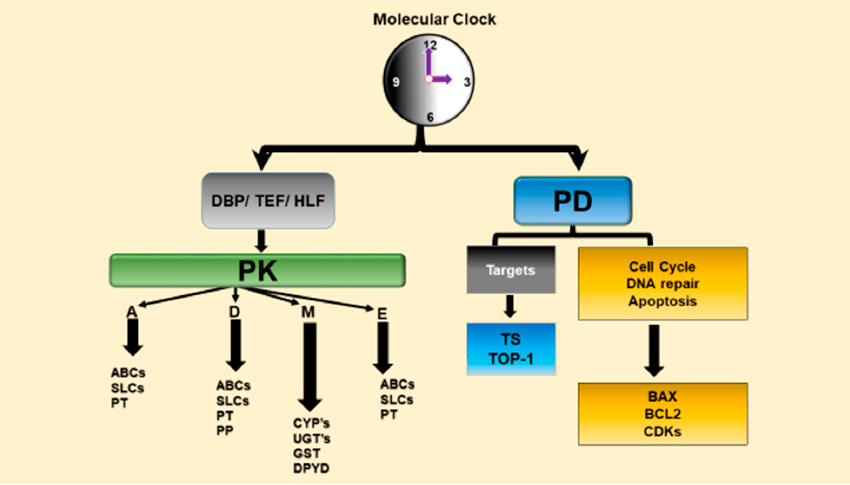
Figure 2. Molecular clock controls PK and PD of anticancer agents. The clock controls main pathways responsible for anticancer drug PK during the 24 h. Circadian clocks also controls several drug targets including cell cycle, DNA repair and apoptosis genes which are contributed to anticancer drugs’ PD.